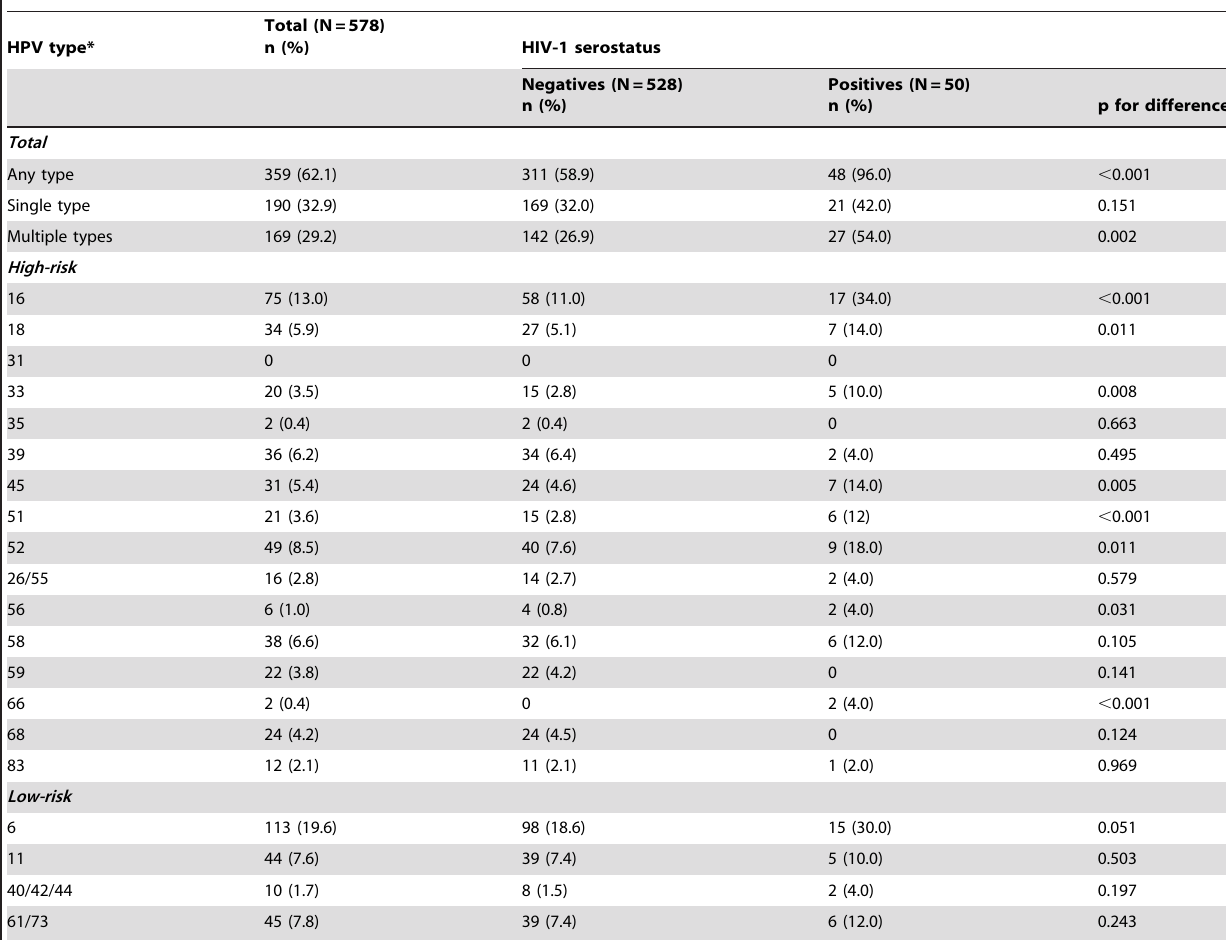
Table 2. Anal HPV type distribution according to HIV-1